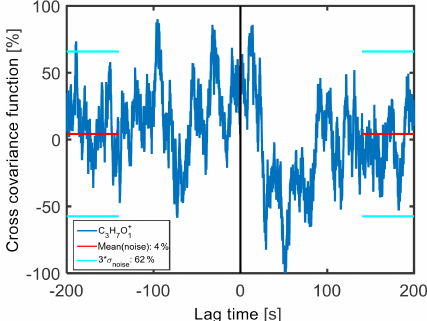
Figure A7. Averaged absolute CCF for C 3 H 7 O + stant lag time, the maximum of the CCF is not always used, as this would overestimate the flux. In this case the value used is actually a local minimum between two maxima.